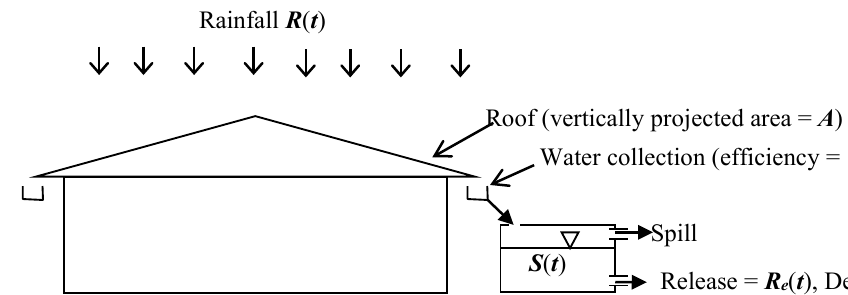
Fig. 1 Illustration of RWH system